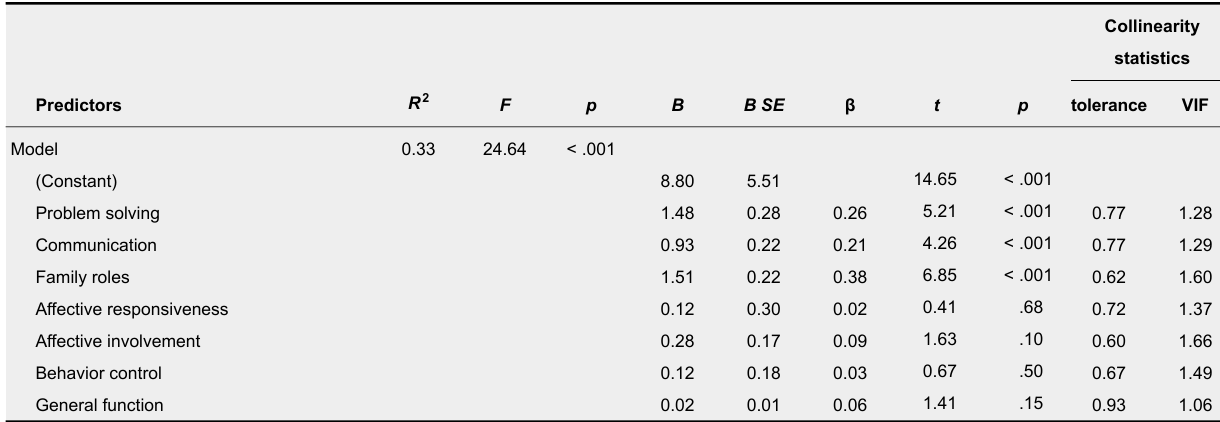
Multiple regression of quality of life on family functions